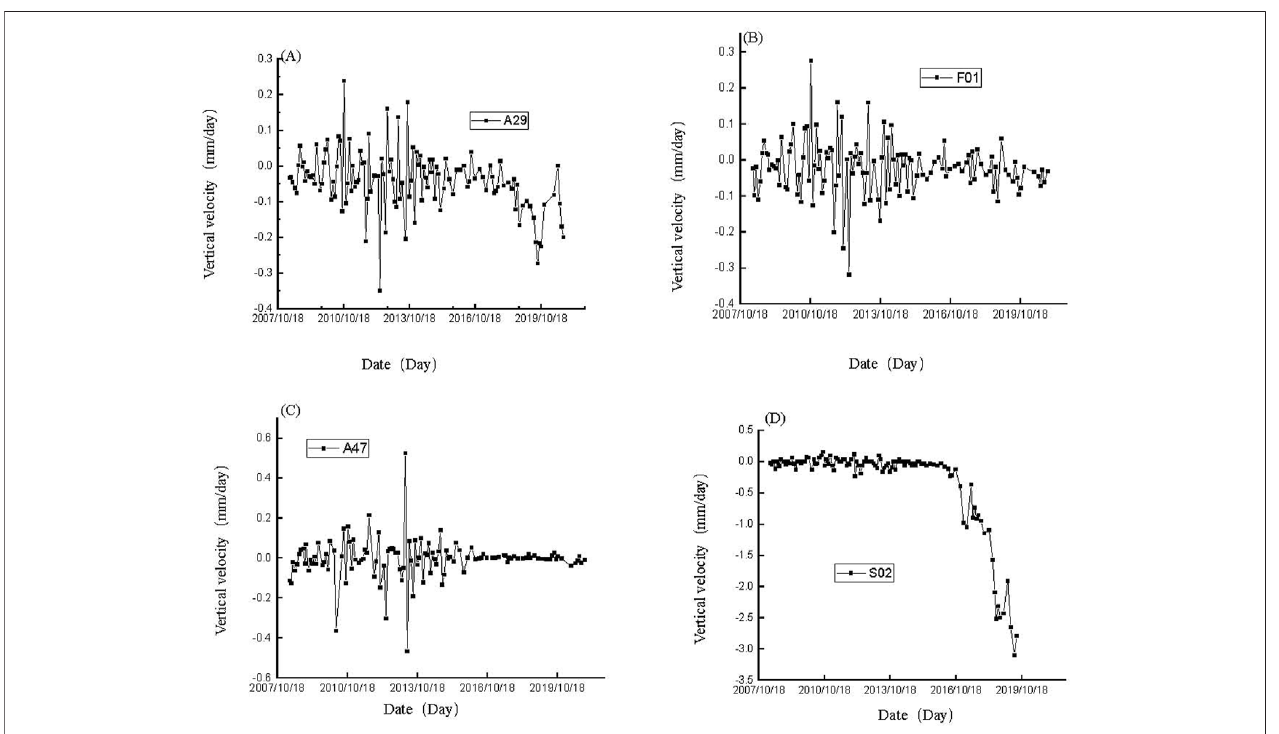
FIGURE 9 | Vertical velocity – time curves (A) A29; (B) F01; (C) A47; (D)